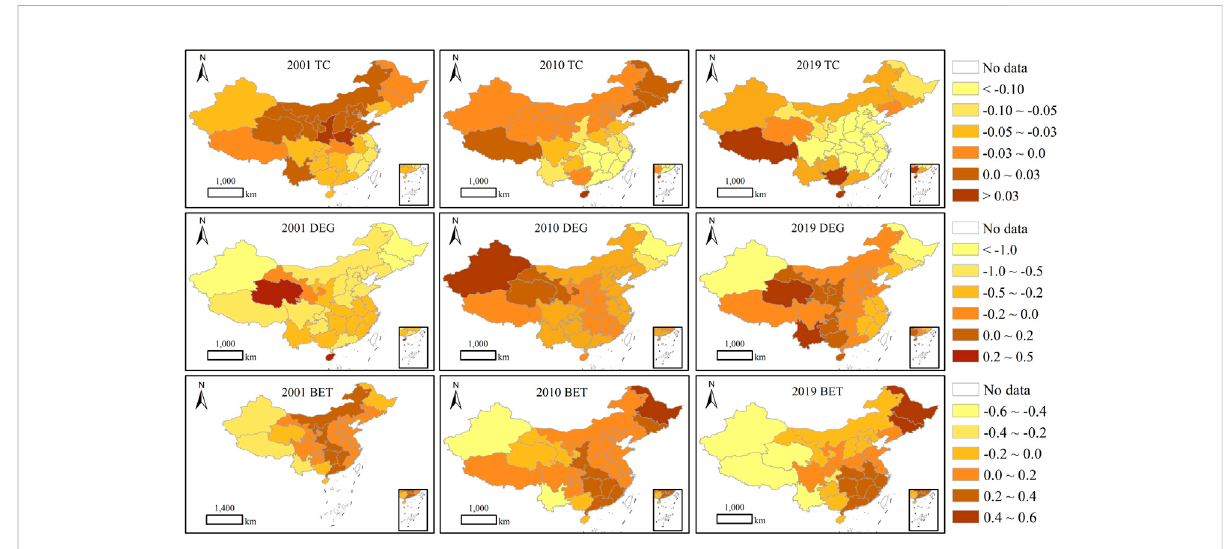
FIGURE 4 Spatiotemporal heterogeneity of the impact of technological progress and centrality on agricultural carbon emissions.